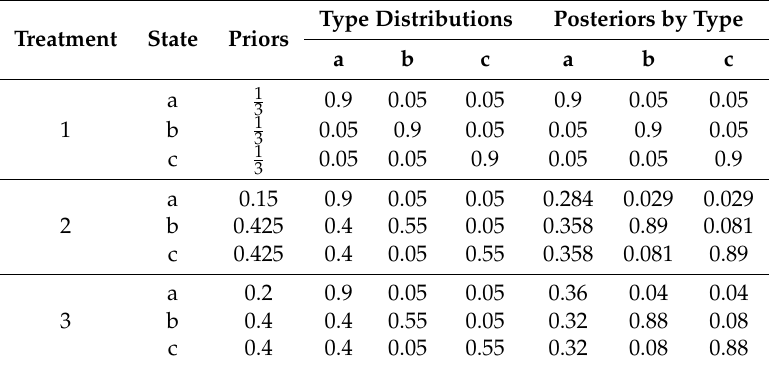
Table 1. Treatment design: priors and type